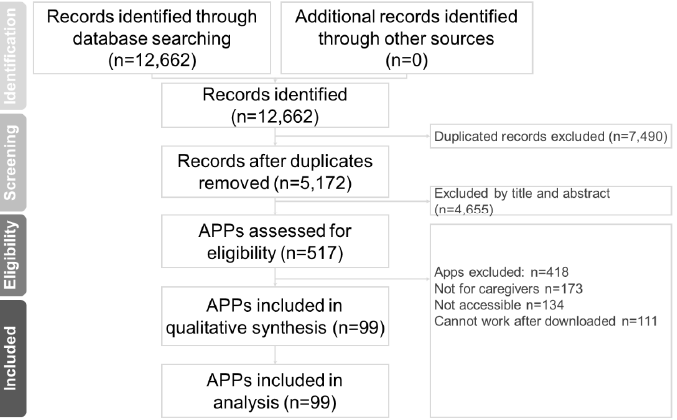
Figure 1. PRISMA flow diagram for searching and identifying included mobile applications.